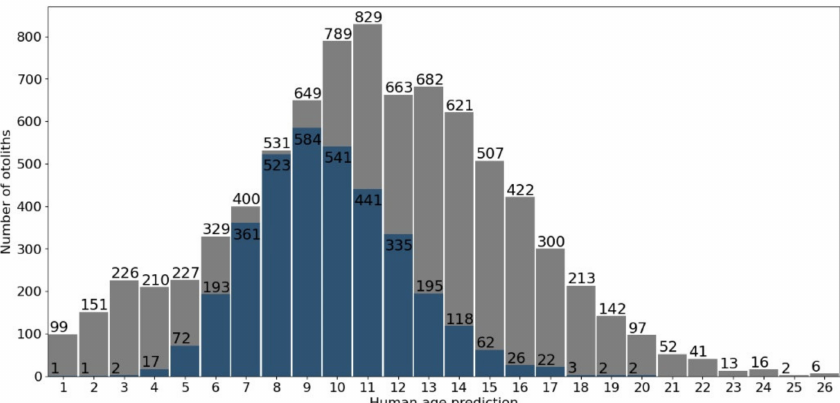
Figure 2. Age frequency distribution of predicted ages by human readers in the Norwegian dataset (gray) and the Icelandic dataset